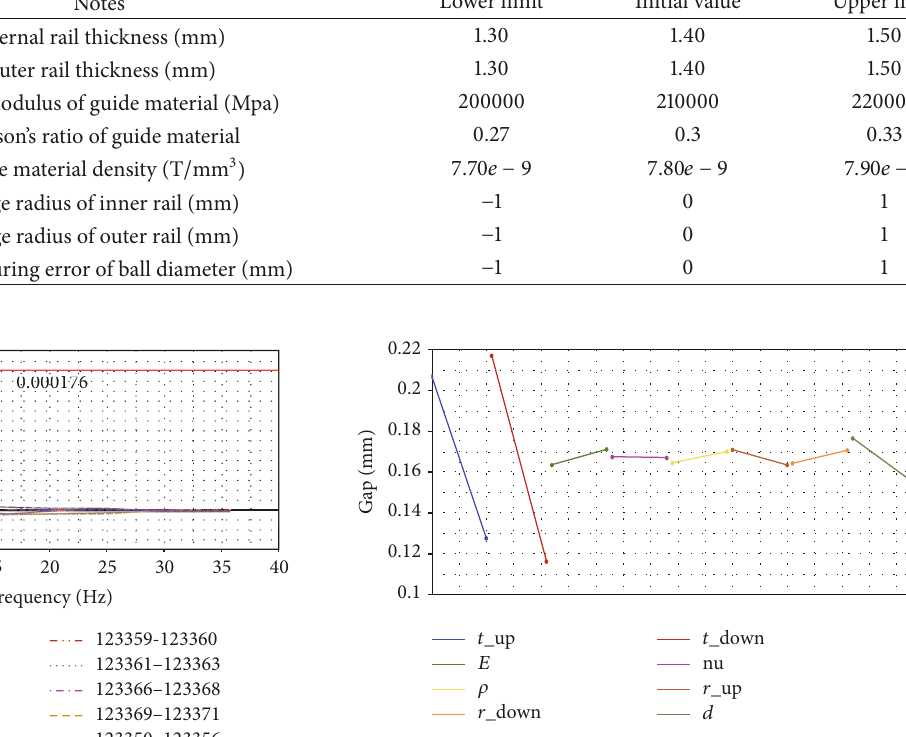
Figure 15: The schematic diagram of the main effect of the design of the Hammersley